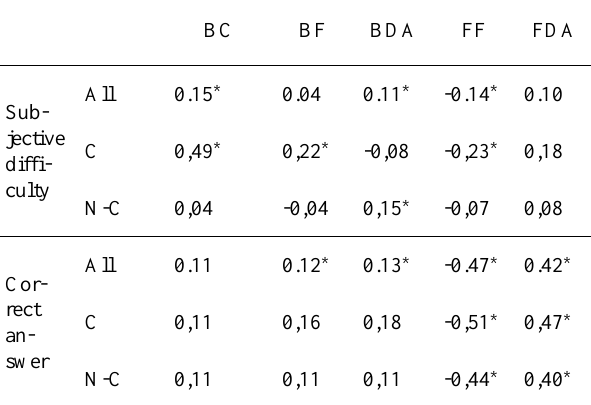
The Pearson’s correlation coefficient for the selected eye- tracking parameters and the evaluation of the task difficulty level and the results